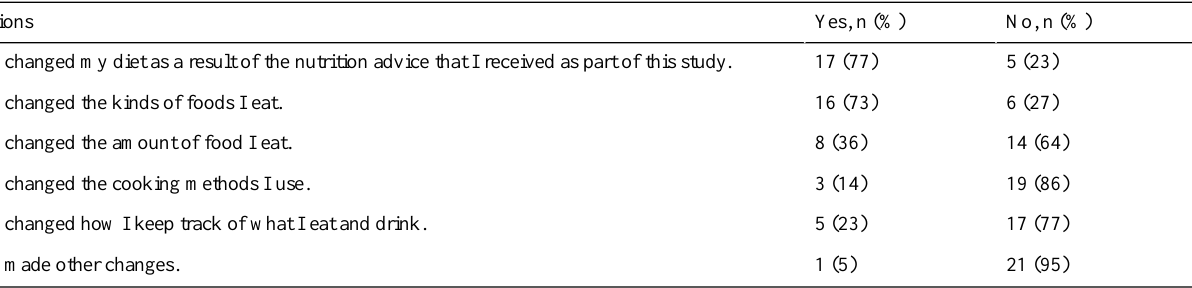
Table 4. Participant’s perceived acceptability for receiving dietary counselling in the Diet Bytes and Baby Bumps study (n=22 a ) (survey questions with yes/no